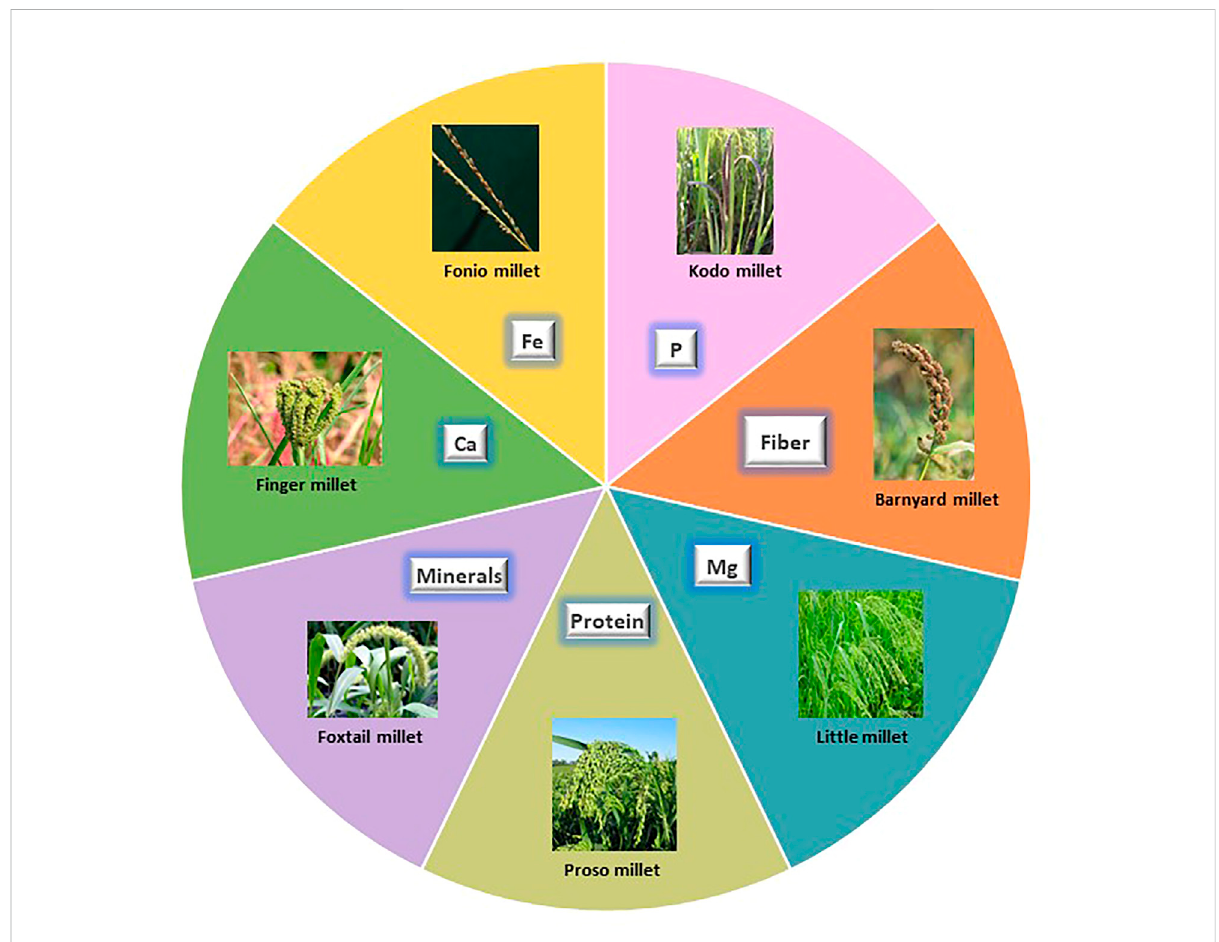
FIGURE 2 Nutritional uniqueness of small millets. Each sphere depicts the specialty of small millets in food.